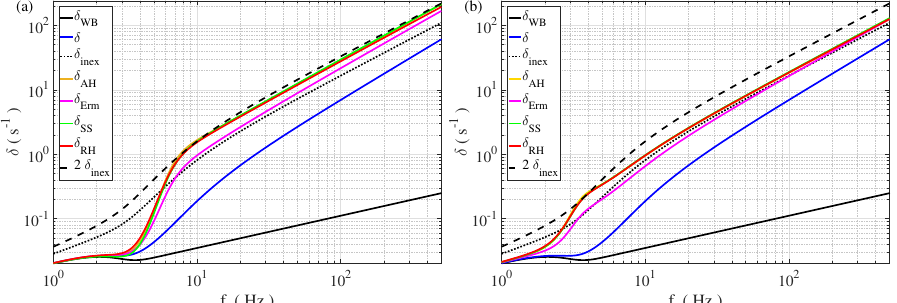
Figure 5. Damping rates of surface waves for a surfactant-contaminated free surface. The values are computed for water with a surface tension γ = 60mN/m, a density ρ = 998kg · m − 3 , and a kinematic viscosity ν = 10 − 6 . The fluid height is H = 50mm, and we consider a rectangular tank of width W = 160mm. The film elasticity is taken to be ( a ) E = 10 mN/m or ( b ) E = 50 mN/m . δ WB is the damping rate due to the walls and the bottom. δ WB is added to all the following damping rates to have the estimation of the total dissipation. δ is the damping rate for a clean free surface. δ inex is the inextensible film model. δ AH , is the model according to Alpers and Hühnerfuss, with a phase angle of the elastic modulus θ = 176 ◦ [58,59]. δ Erm (Equation (71)) is the model according to Ermakov [60]. δ SS is the surfactant–surface model for an insoluble surfactant and the negligible shear and dilational viscosities of the surfactant film [32,56]. δ RH is the model according to Rajan and Henderson for large Reynolds number and neglecting the air density (see Equation (75) in [32]). For f > 7Hz, the expected damping rate is well approximated by 2 δ inex when E = 10 mN/m ( a ), and by δ inex when E = 50 mN/m ( b